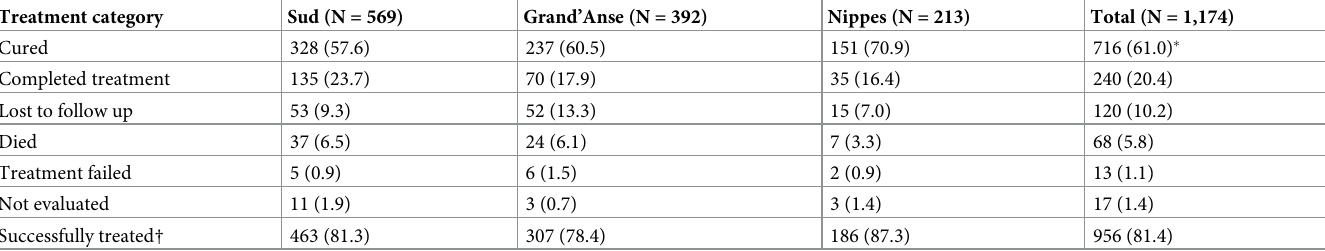
Table 2. Outcomes for patients receiving anti-TB treatment in the affected departments before Hurricane Matthew.